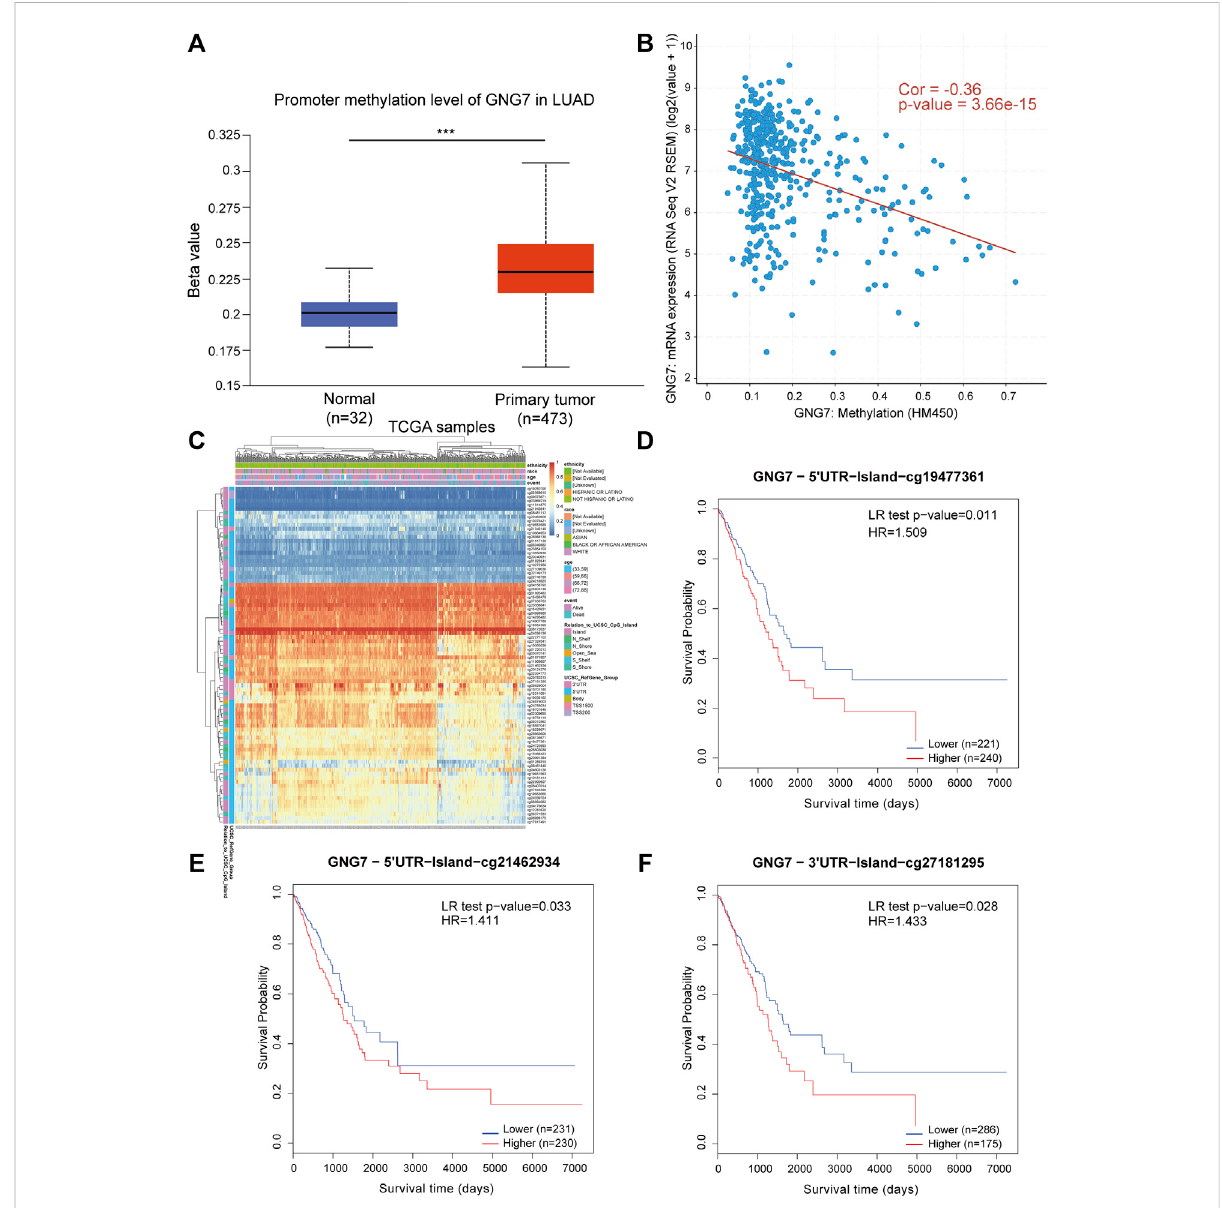
FIGURE 8 DNA methylation levels of GNG7 and its prognostic value in LUAD. (A) The promoter methylation level of GNG7 in normal tissues and primary LUADtissuesbytheUALCANdatabase. (B) ThecorrelationbetweenGNG7methylationanditsexpressionlevel. (C) TheheatmapofDNAmethylation at CpG sites in the GNG7 gene by the MethSurv database. (D – F) Kaplan-Meier survival curves of OS based on methylation at GpG sites of cg19477361 (D) , cg21462934 (E) and cg27181295 (F) in